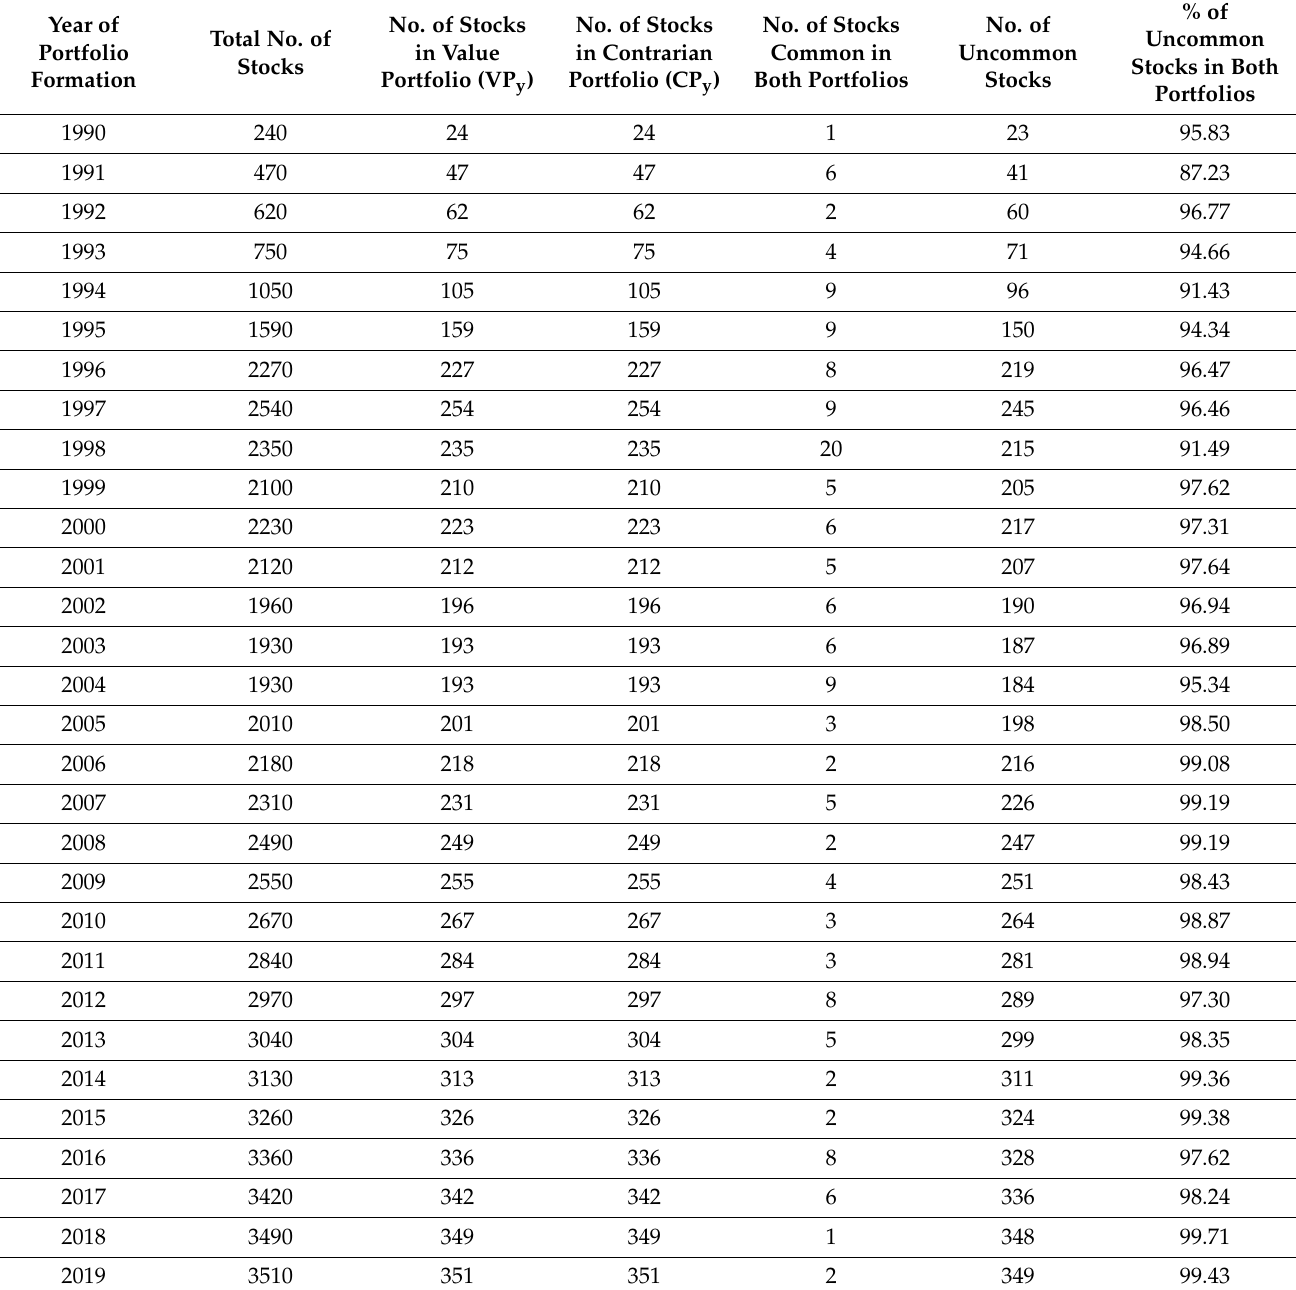
Table 1. Stocks in value portfolio (VP y ) and contrarian portfolio (CP y